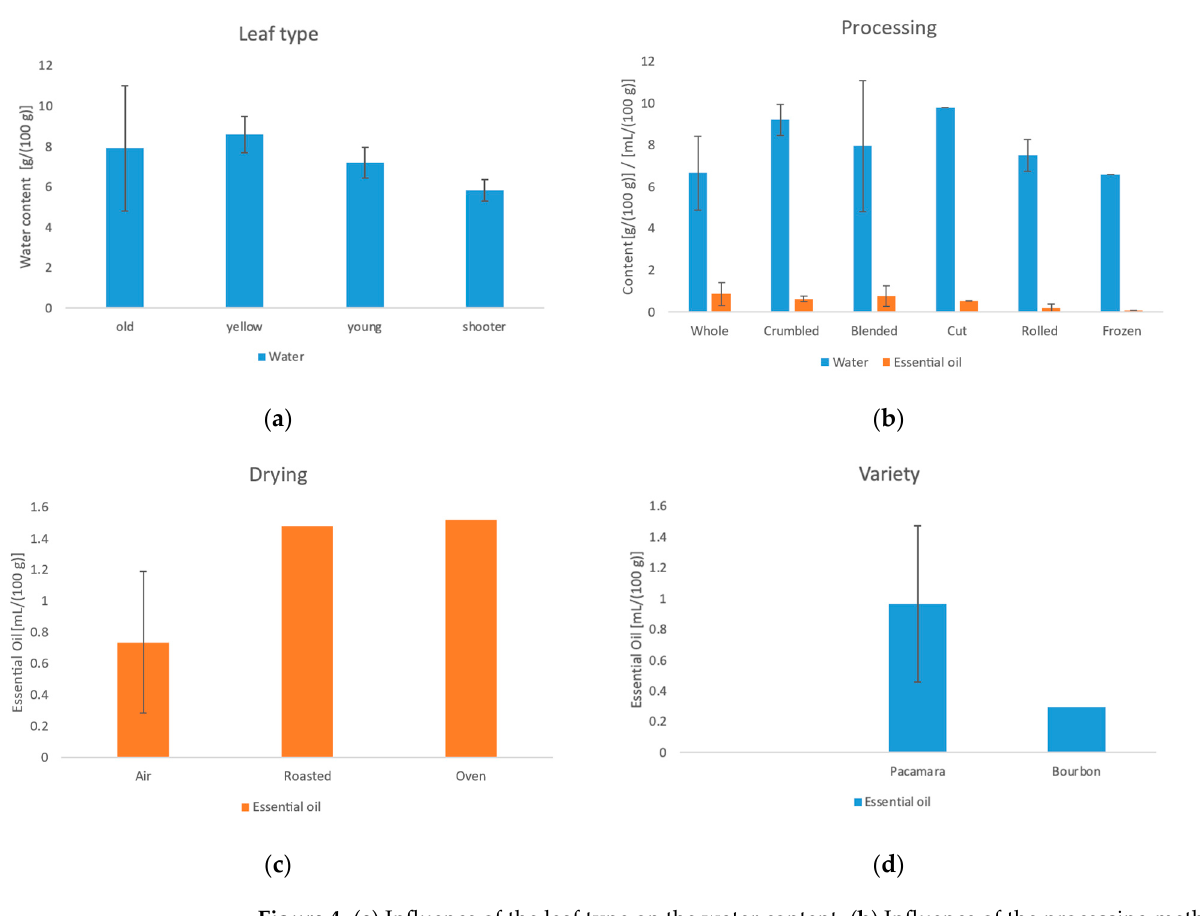
Figure 4. ( a ) Influence of the leaf type on the water content. ( b ) Influence of the processing methods on the water (g/100 g) and the essential oil content (mL/100 g). ( c ) Influence of the drying method on the essential oil content. ( d ) Influence of the variety on the essential oil content.